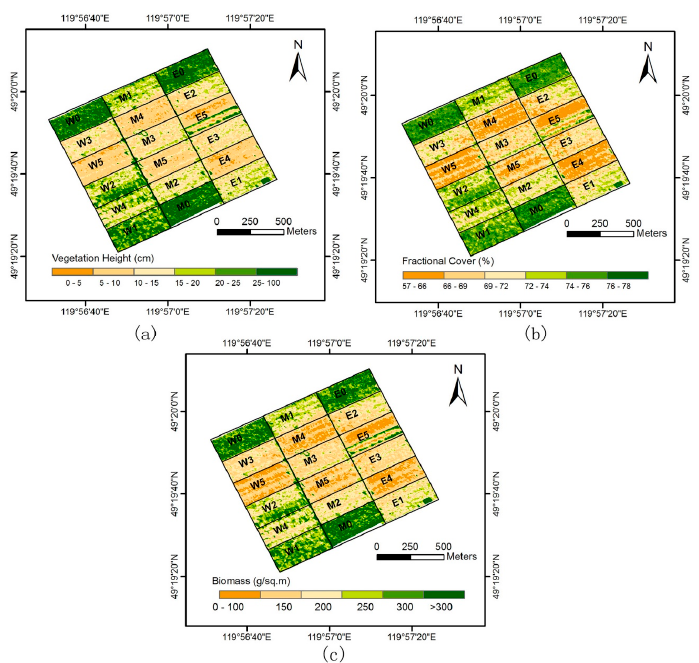
Figure 7. Predicted maps. ( a ) Canopy height map predicted using the mean lidar-derived height; ( b ) Fractional cover map predicted using the lidar-derived fractional cover; ( c ) Aboveground biomass map predicted using the mean lidar-derived height.